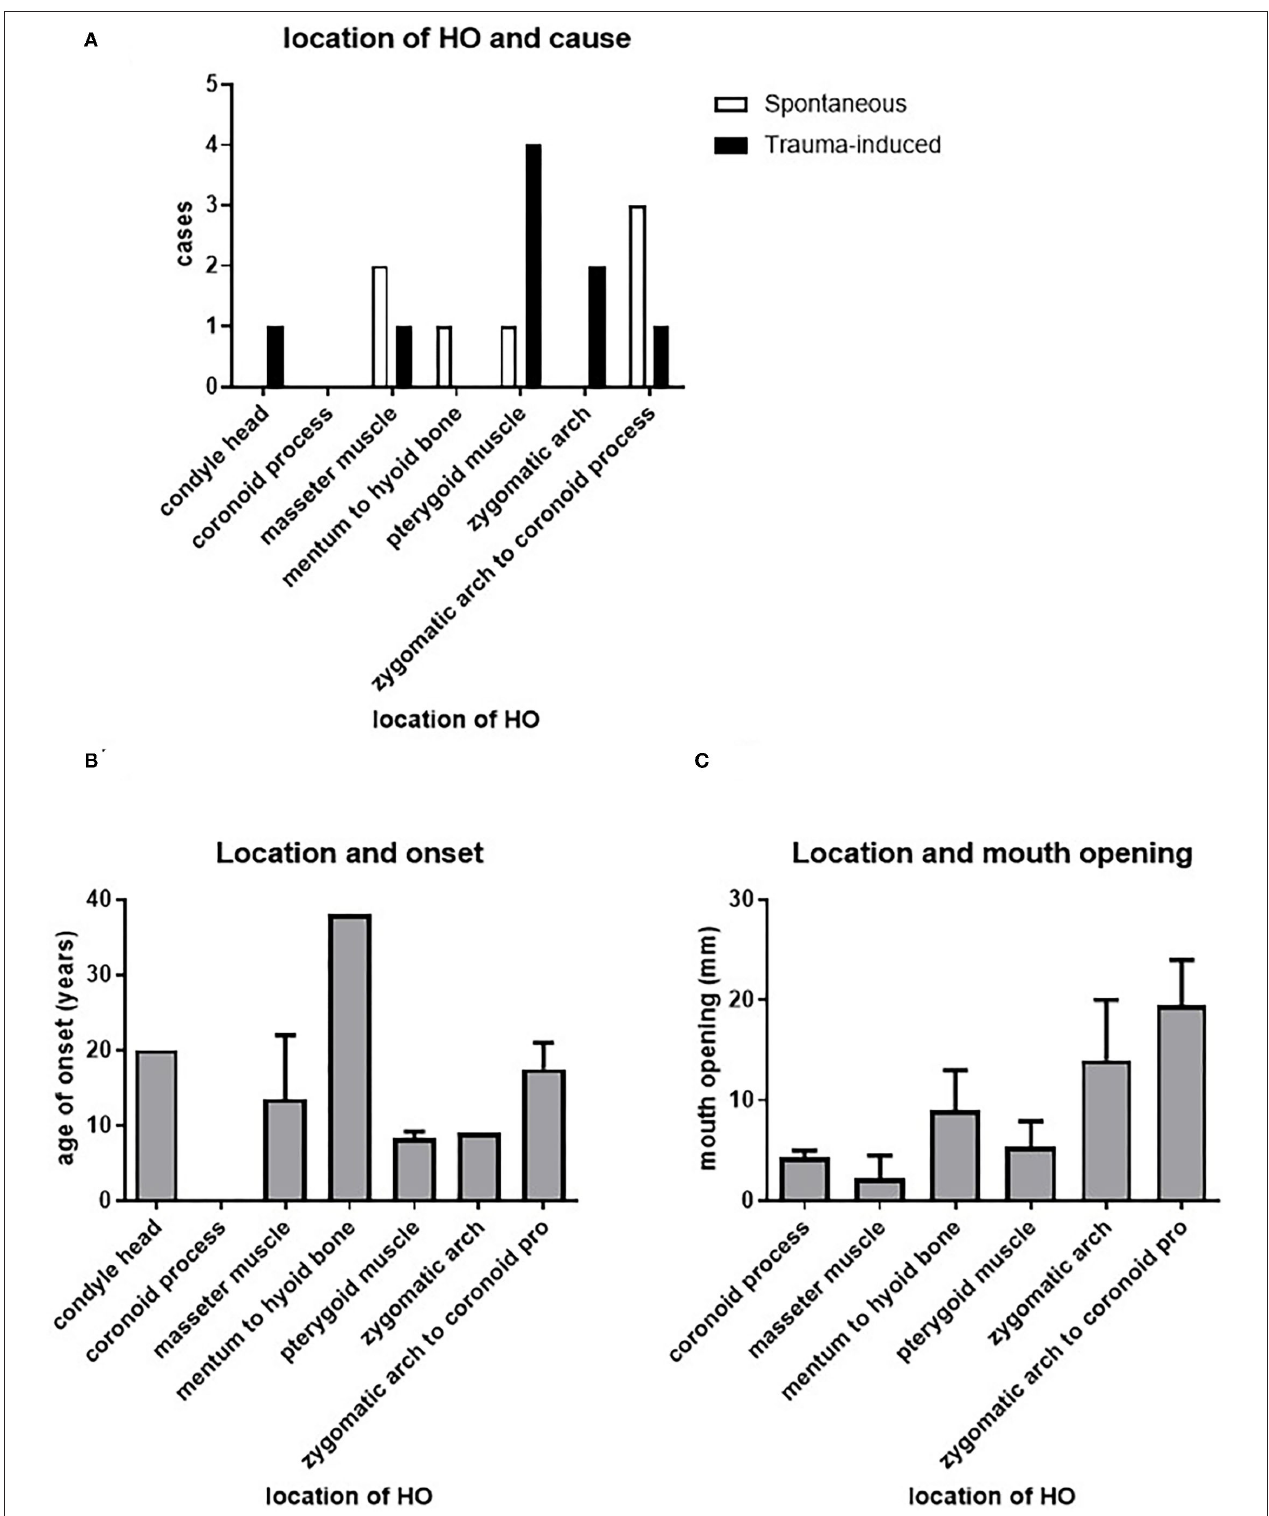
FIGURE 5 | Relation between HO and location. There does not seem to be a correlation between the cause of HO or the age of onset of HO and its location (A,B) . The different possible locations of HO seem to differ in their effect on maximal mouth opening, with a significant difference between HO in the masseter muscle and HO between the zygomatic arch and the coronoid process (C)